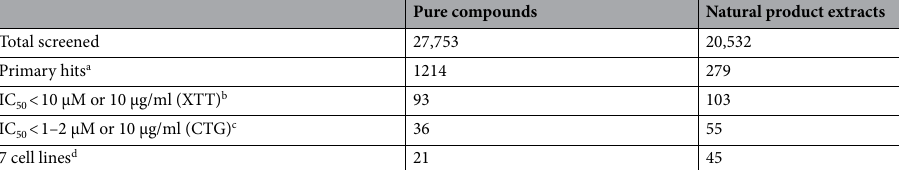
Table 2. HTS results. a Viability reduced to < 50% at 3 days in at least one MCC cell line (MCC26 or MKL- 1) and no general toxicity using 1 or 10 µM of pure compounds, 1 or 10 µg/ml of natural product extracts. b